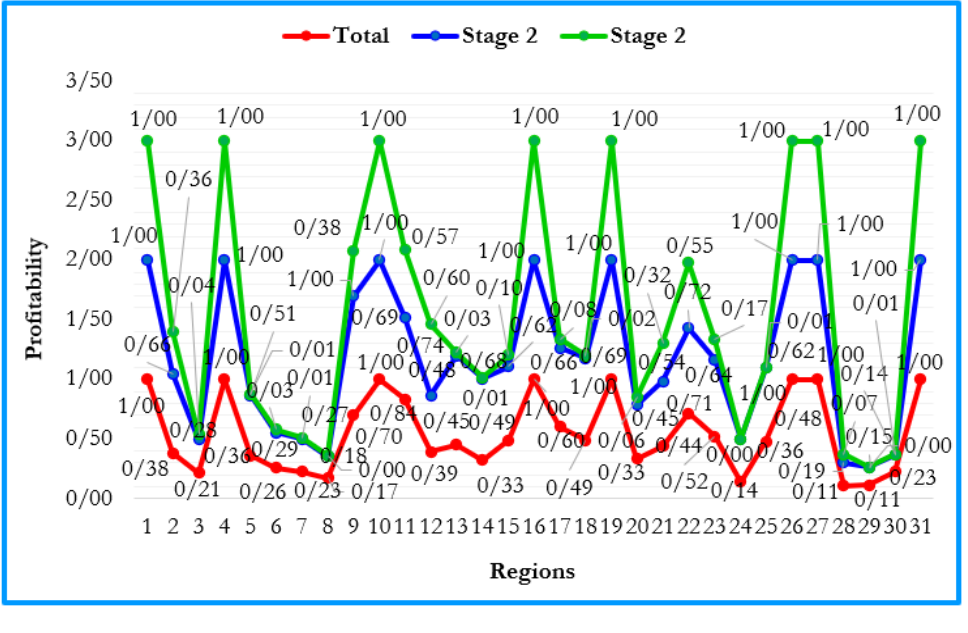
Fig. 3. Profitability of 31